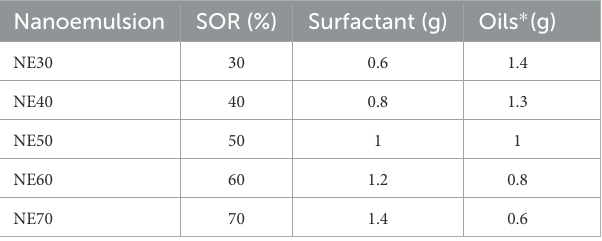
TABLE 1 Different proportions (SOR, %) of surfactants and oils used to prepare the nanoemulsions with the low-energy nanoemulsification